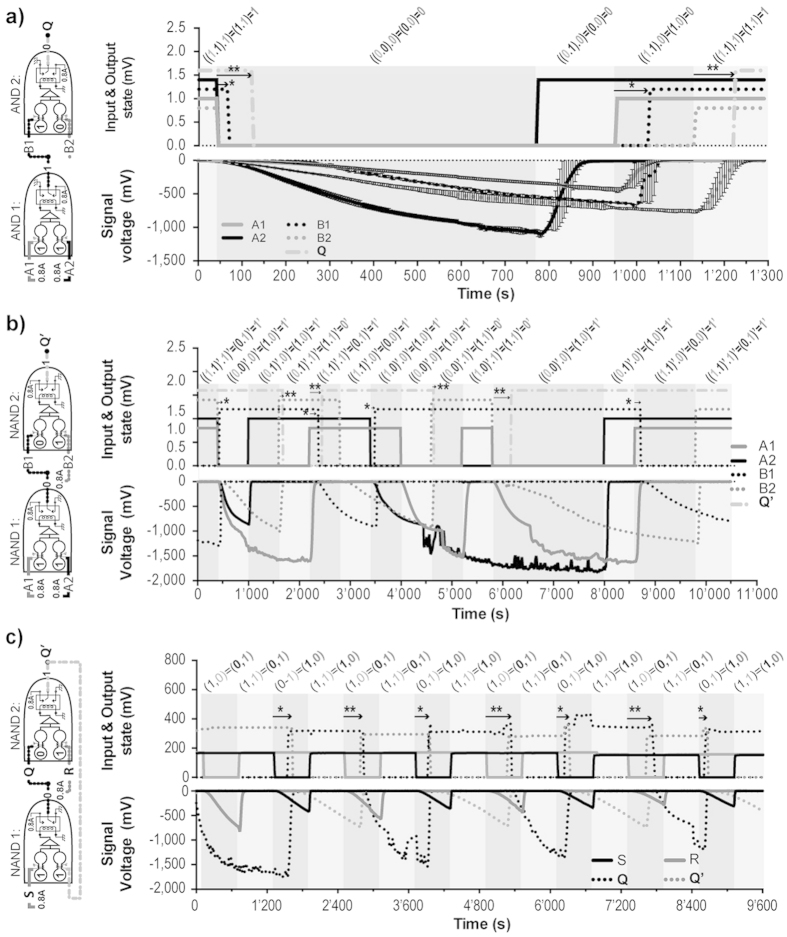
Cascading logic gates illustrating the signal responses of the H-tubes to data inputs.(a) Cascading AND gates. Error bars stand for the standard deviation (n = 3). (b) Cascading NAND gates. (c) Low SR NAND Gate Latch. The coloured sections indicate manual switching. The * represent the propagation delay of the first gate, and ** the propagation delay of the second gate. In (a,b) the voltages of the gates (above 0 mV) are arbitrary values indicating when the coils were switched on. In (c) the curves above 0 mV are the measured voltages of the coils.